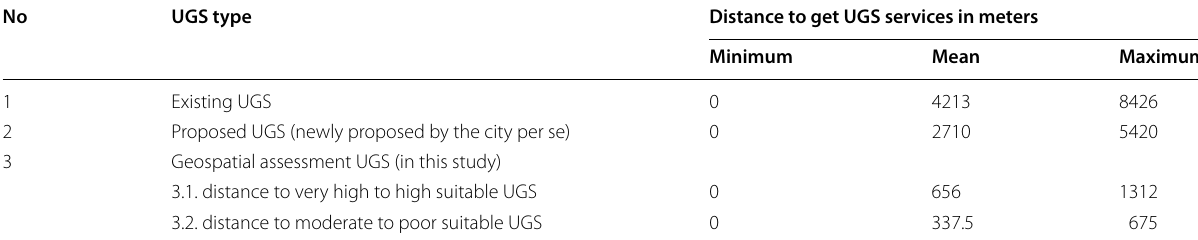
Table 8 Distance to get UGS service of existing, proposed, and geospatial assessment studied UGS in DMC